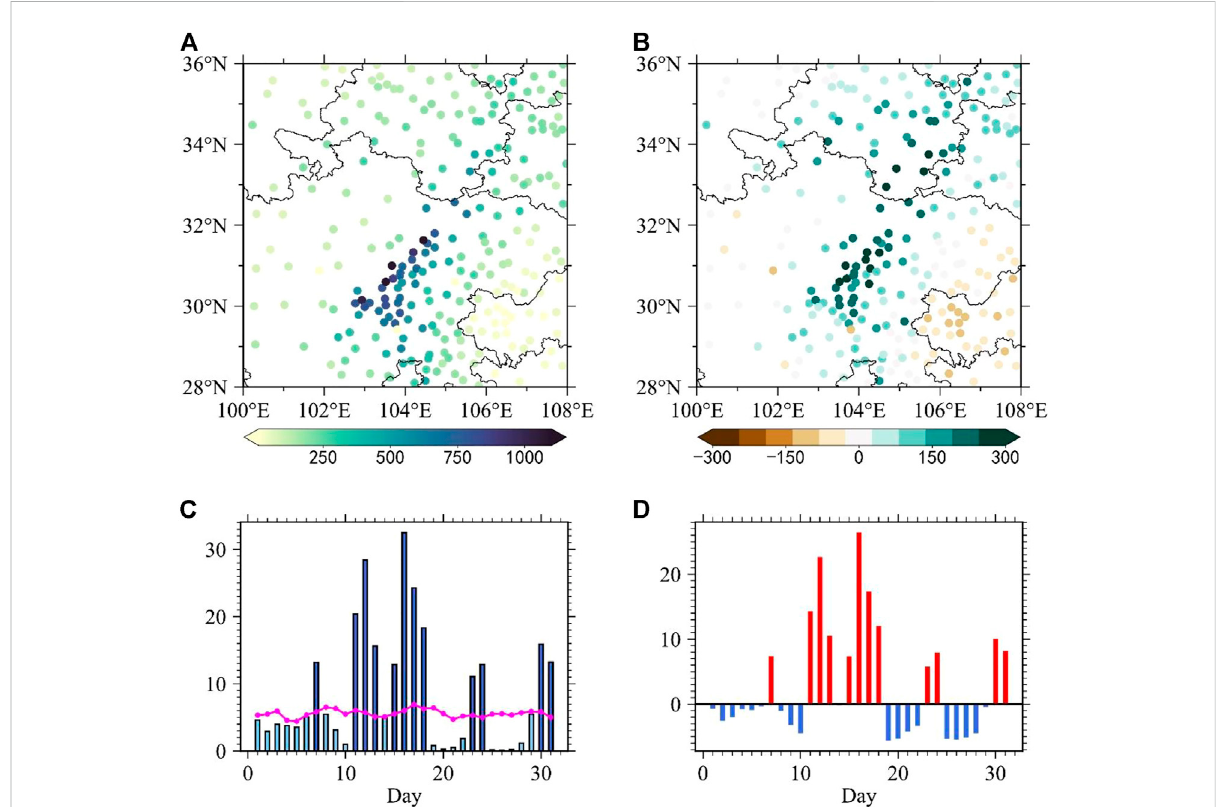
FIGURE 3 Spatialdistributionof (A) precipitation(Unit:mm)and (B) precipitationanomalypercentage(Unit:%)inAugust2020inWC. (C) and (D) showthe daily precipitation and precipitation anomalies (Unit: mm) in August 2020 in WC (Dark blue histogram and red line in (C) represent precipitation exceeding the August 2020 average and climatological daily mean precipitation in August during 1961 – 2021,